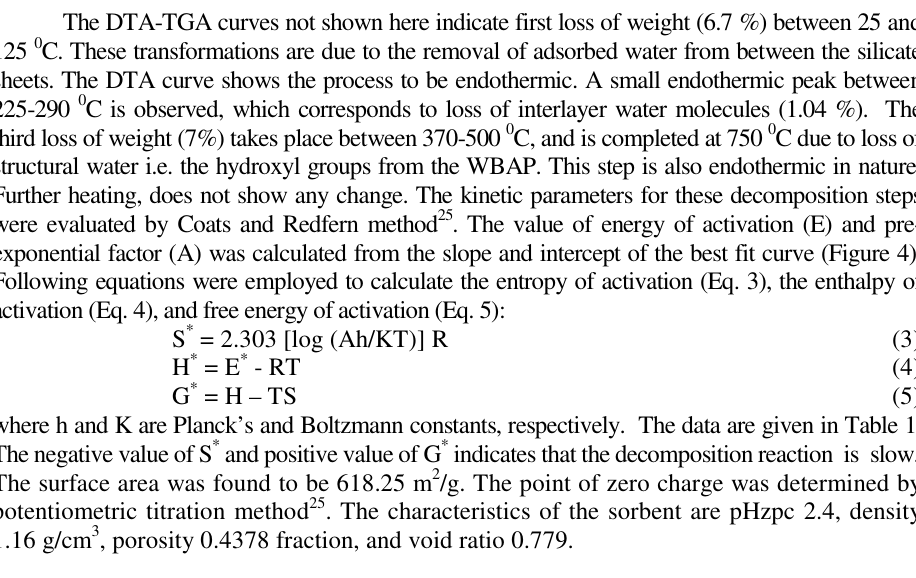
Figure 3. TEM photographs and SAED pattern of WBAP and Cu sorbed